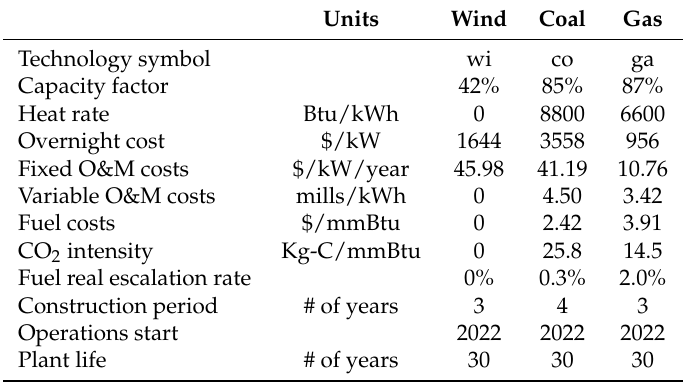
Table A1. Technical assumptions. All dollar amounts are in year 2015 dollars. Overnight costs are assumed to be uniformly distributed on the construction period. O&M stands for operation and